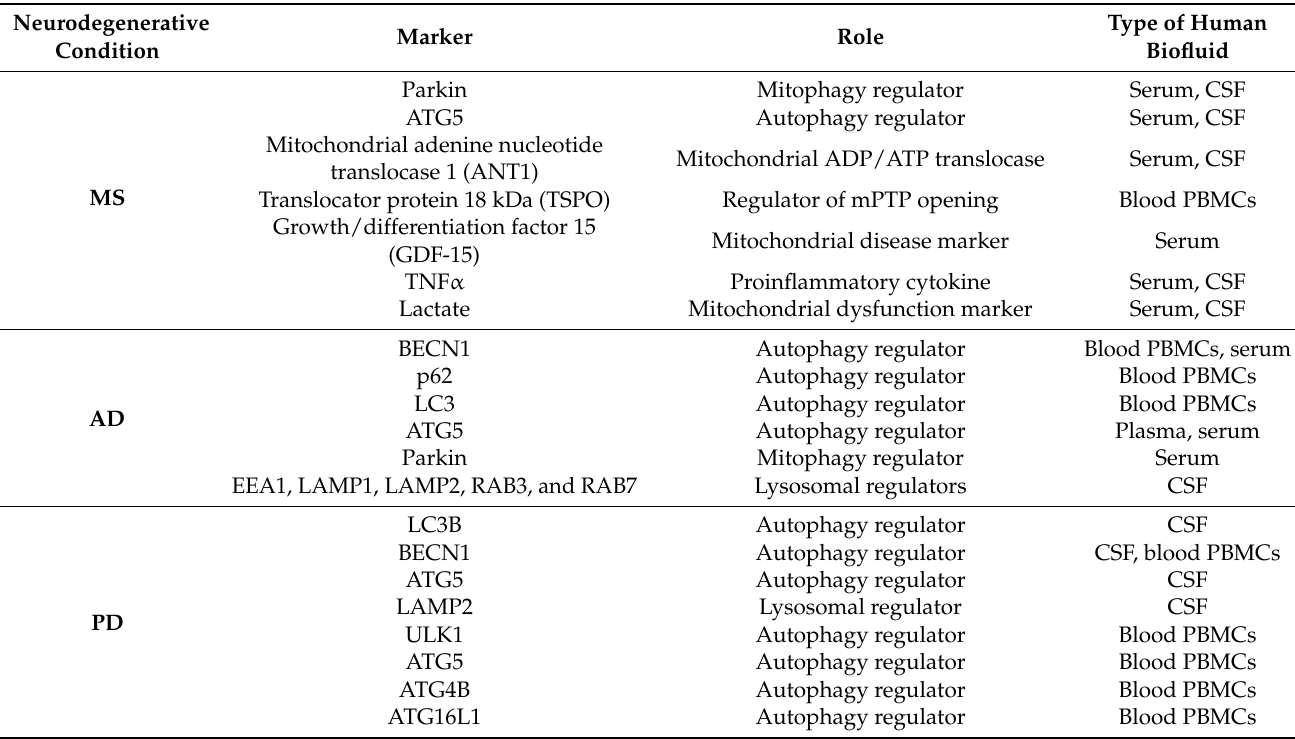
Table 1. Summary of autophagy- and mitophagy-related markers in biofluids of MS-, AD-, and PD-affected persons.